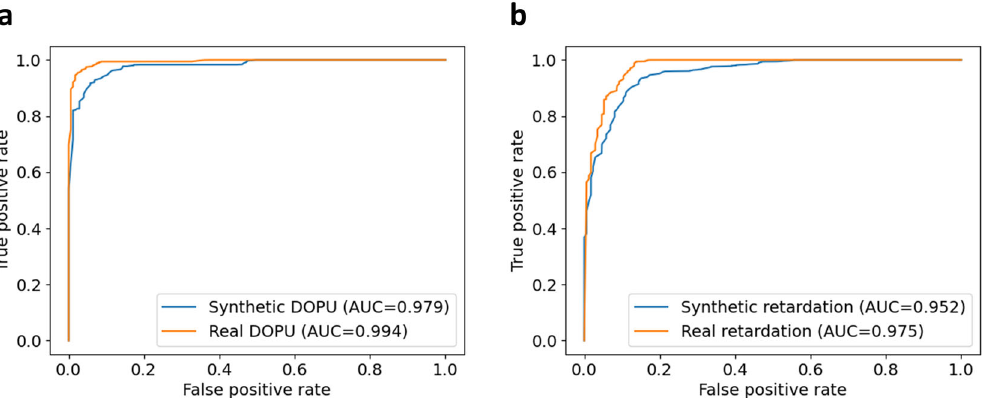
Fig. 3 ROC curves of cancer/normal classi fi cation using real and synthetic PS-OCT images. Classi fi cation results trained on ( a ) DOPU and ( b ) phase retardation contrasts. The ROC curves of the synthetic images are largely overlapping with the curves of the real images, and the AUC of the two curves are also